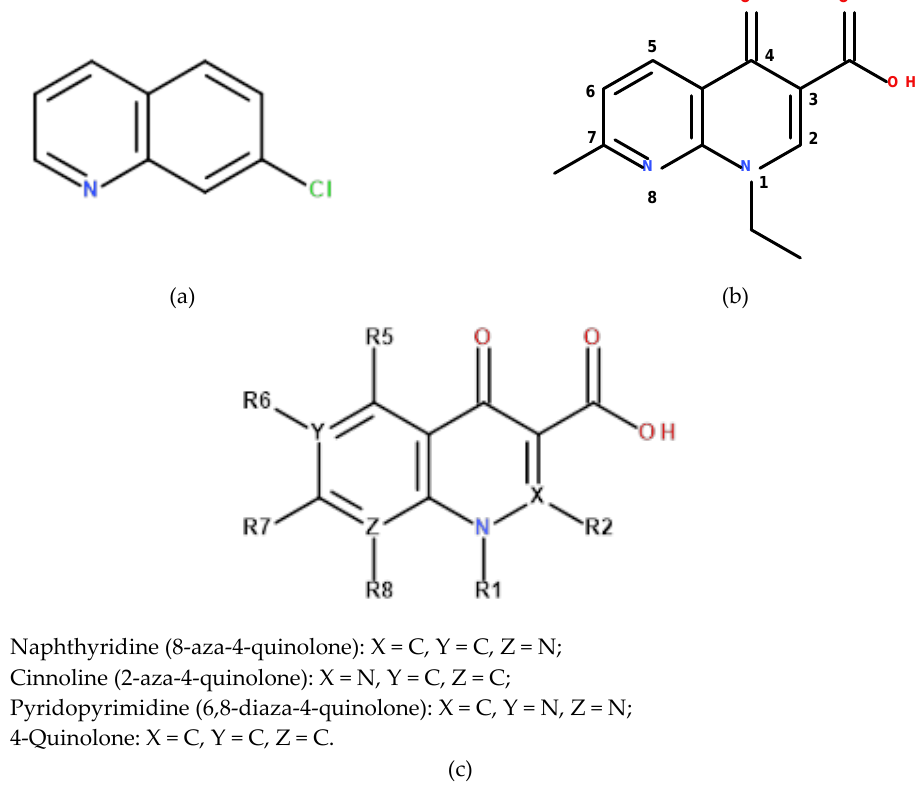
Figure 1. ( a ) 7-chloroquinoline; ( b ) nalidixic acid; ( c ) general structure and main classes of quinolones.